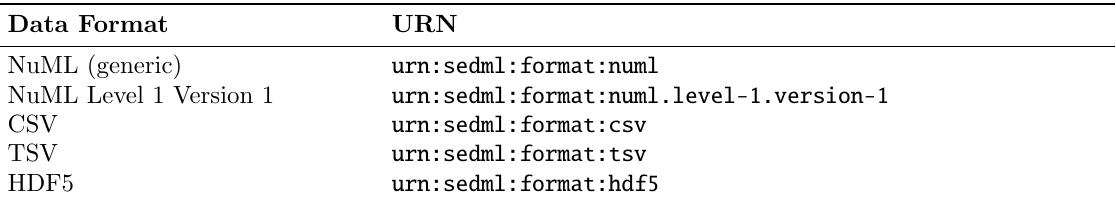
Table 3.3: Predefined dataDescription format URNs. The latest list of format URNs is available from https://sed-ml.org/urns.html